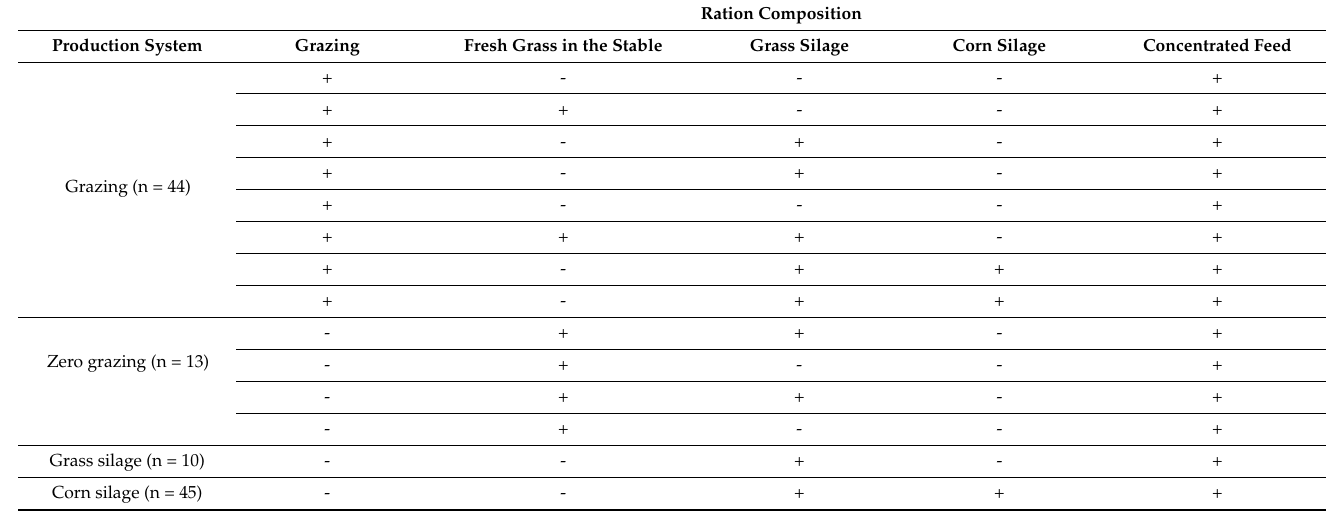
Table 4. Classification of the farms in the study based on milk production